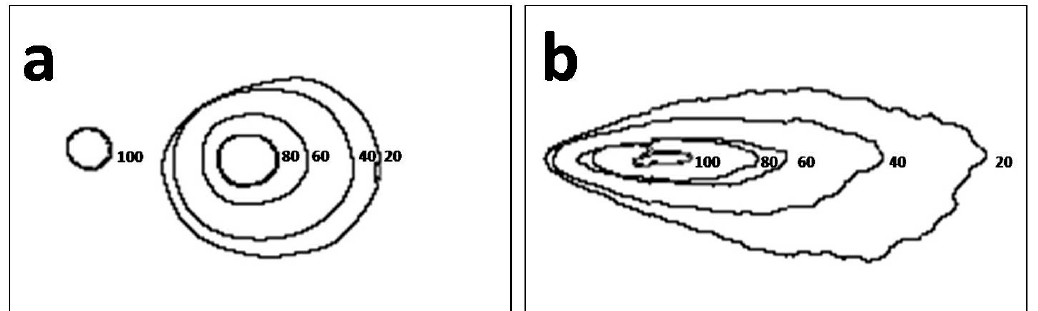
Figure 11. Intensity contour plots of primary ( a ) and secondary ( b ) plumes, obtained by ICCD images. The numbers indicate the intensity of the contours in an arbitrary scale. The data have been recorded at 100 ns and 2 μ s after the laser shot, respectively. The temporal gate was 100 ns in the first case and 500 ns in the second one.